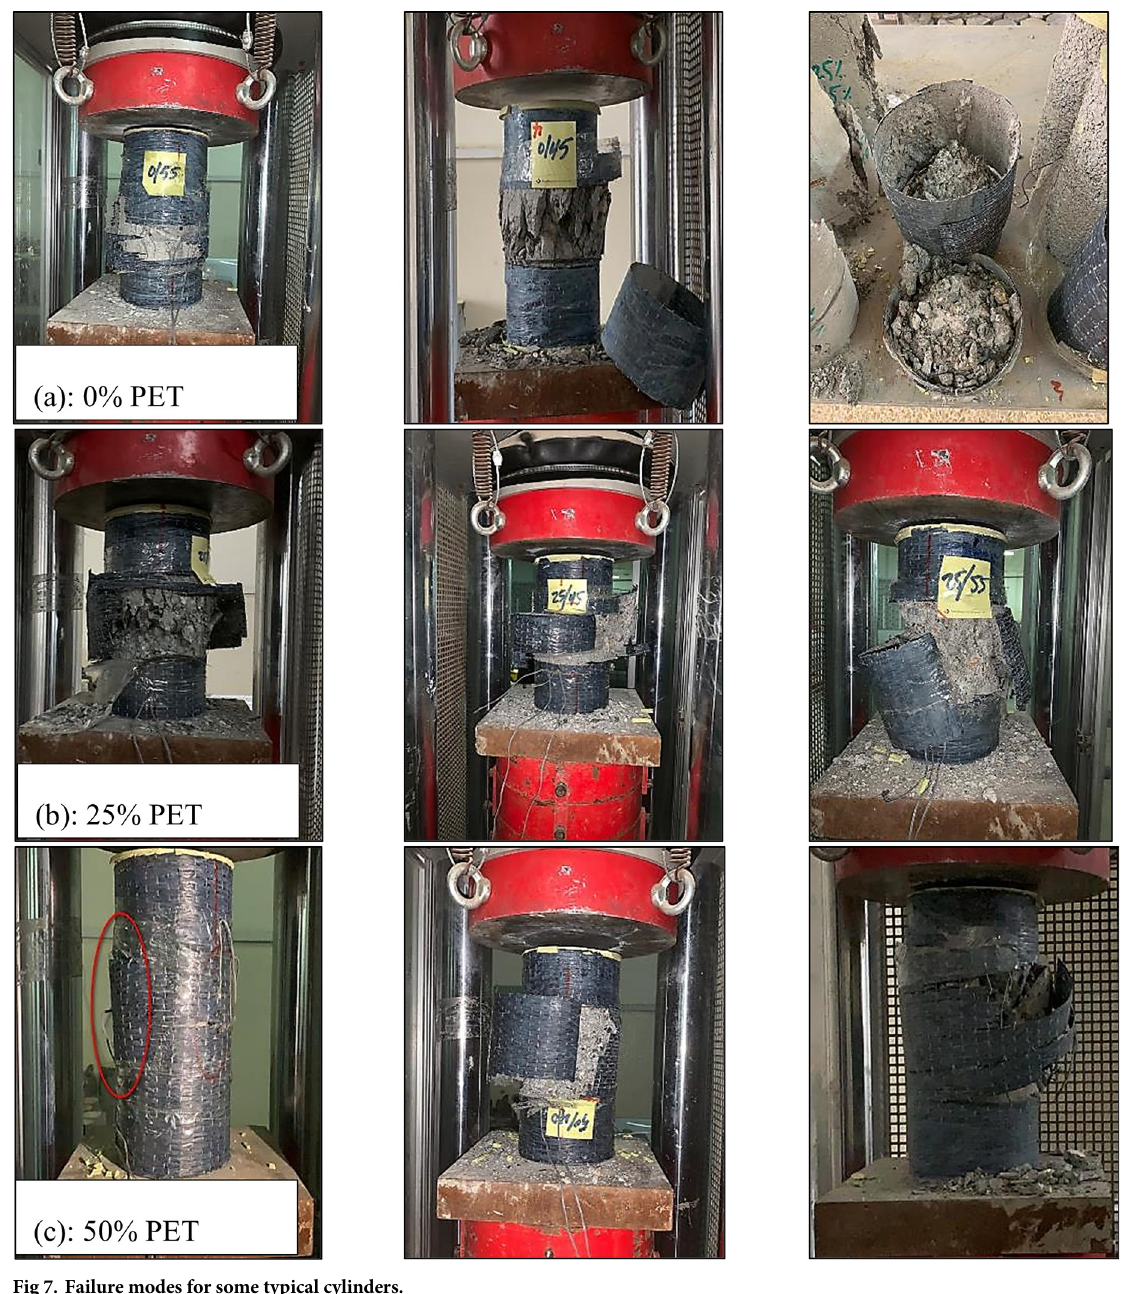
Fig 7. Failure modes for some typical